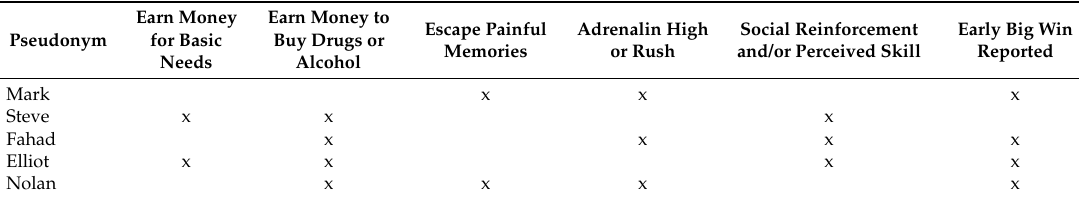
Table 2. Reasons for gambling in youth as reported by case study